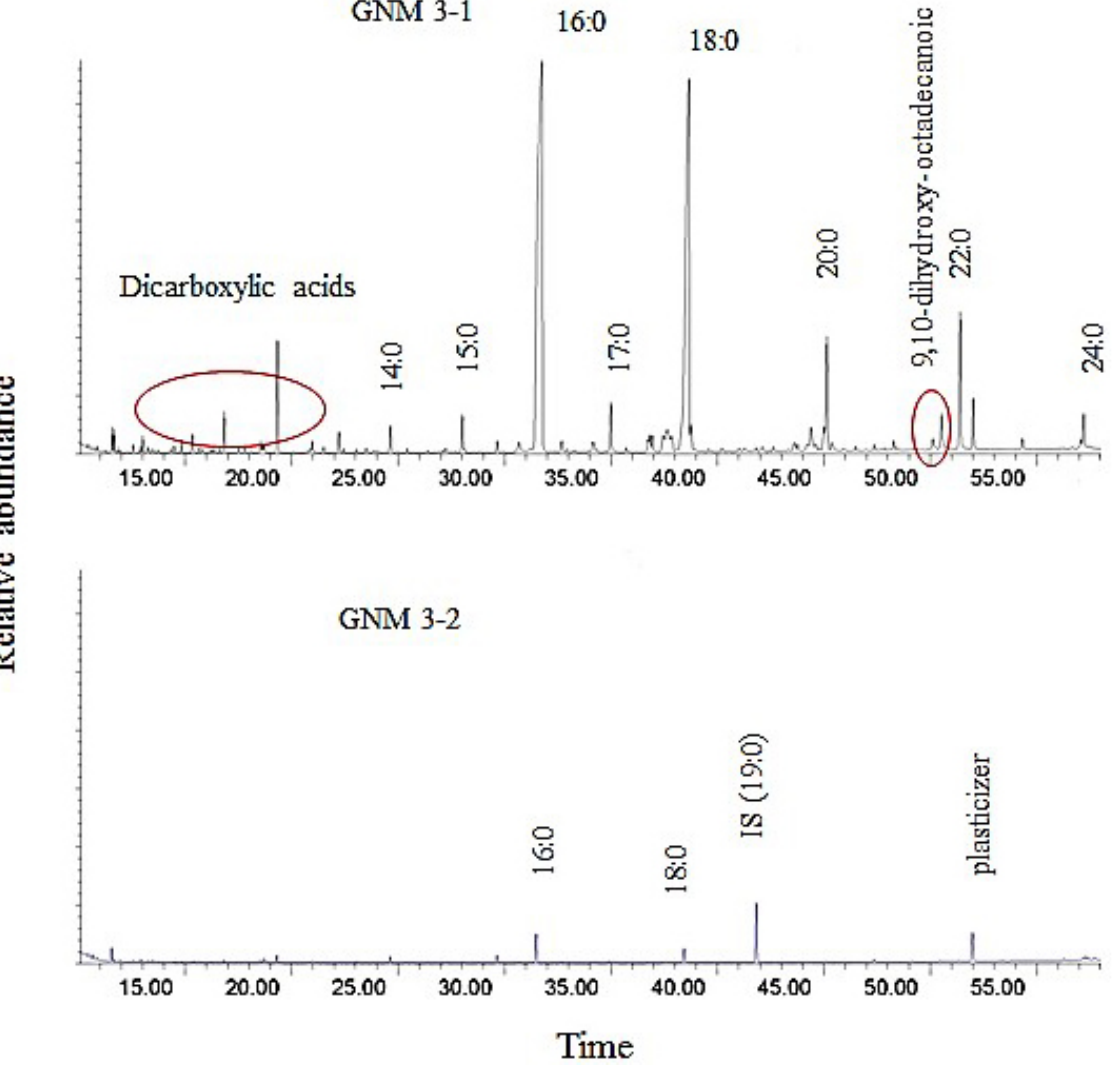
Figure 9. Partial total ion chromatograms for the grinding surface core (upper TIC) and control sample (lower TIC) from RMP-33. Peaks in the upper and lower TICs are plotted to the same